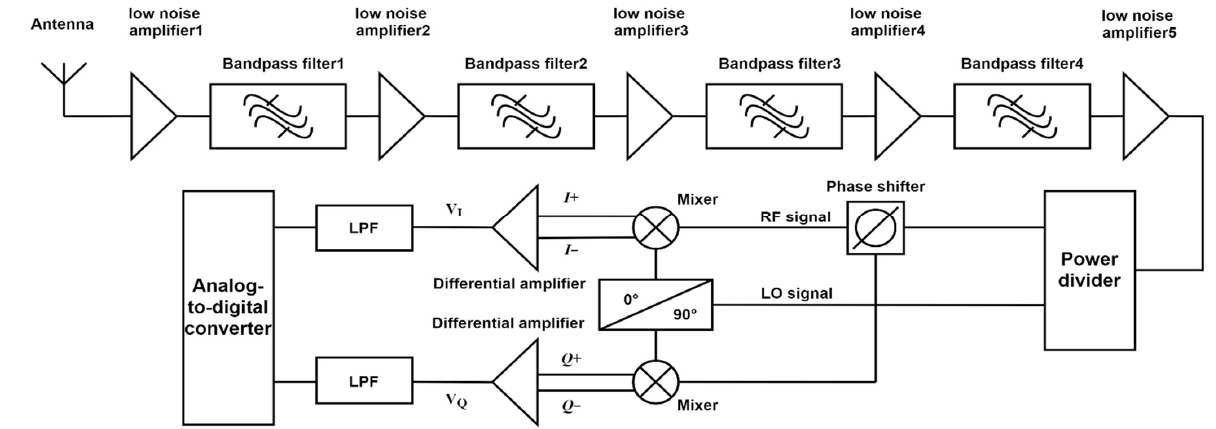
Figure 2. Design block diagram of a broadband microwave receiver.